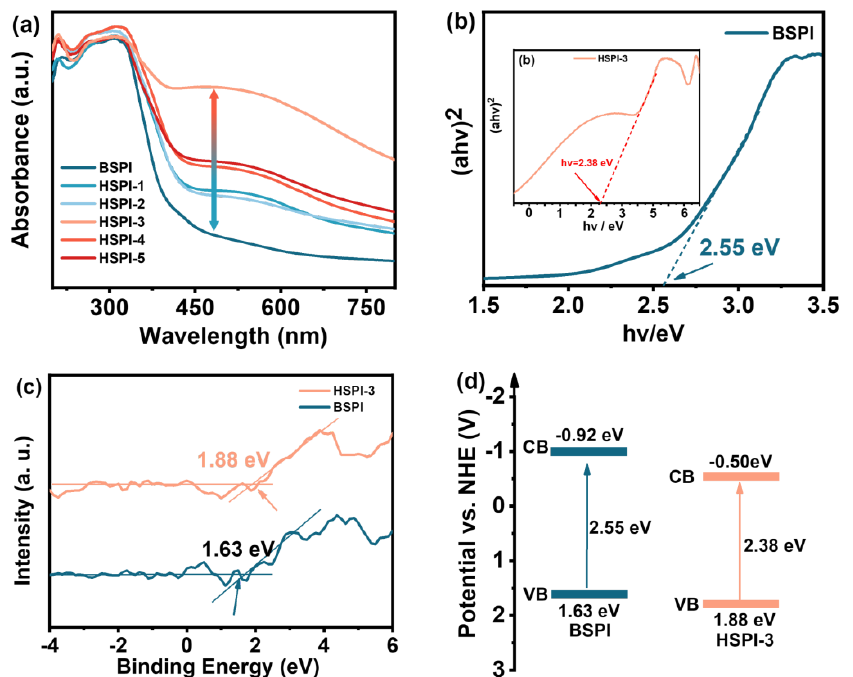
Figure 7. ( a ) UV–vis DRS spectra of BSPI and HSPI with different thicknesses. ( b ) The corresponding plots of ( α · h ν ) 2 versus h ν of BSPI and HSPI-3. ( c ) VBXPS plots of BSPI and HSPI-3. ( d ) Schematic Figure 7. ( a ) UV – vis DRS spectra of BSPI and HSPI with different thicknesses. ( b ) The corre- illustration of band structures for BSPI and sponding plots of (α · hν) 2 versus hν of BSPI and HSPI -3. ( c ) VBXPS plots of BSPI and HSPI-3. ( d ) Schematic illustration of band structures for BSPI and HSPI-3.